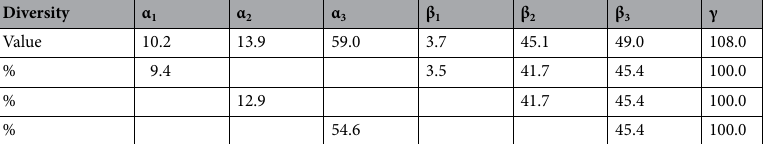
Table 3. Partitioning of plant diversity, according to the hierarchical model of additive partitioning. Partition of γ diversity into its α and β components at three spatial scales (i) among plots within the same forest; (ii) among forests within the same type; and (iii) among forest